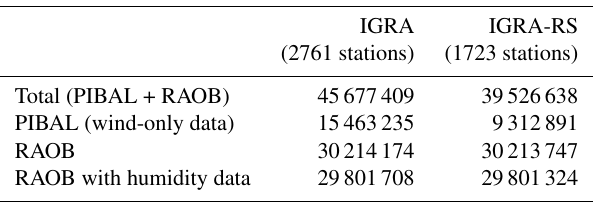
Table 1. Number of soundings in IGRA and IGRA-RS subset until the end of 2016. IGRA IGRA-RS (2761 stations) (1723 stations) Total (PIBAL + RAOB) 45677409 39526638 PIBAL (wind-only data) 15463235 9312891 RAOB 30214174 30213747 RAOB with humidity data 29801708